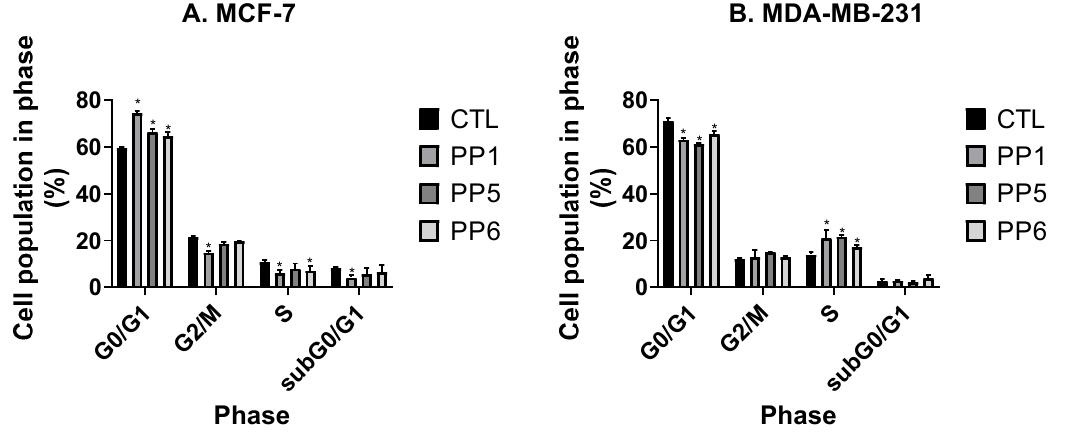
Figure 4. PP1, PP5, and PP6 block MCF-7 cells in G0 / G1 and increase the proportion of MDA-MB-231 cells in G0 / G1. MCF-7 ( A ) and MDA-MB-231 ( B ) (2.5 × 10 5 cells / well) were seeded in six-well-plates in complete media. 24 h later, cells were incubated with media containing 1% FBS and 100 µ M PhytoPs or vehicle alone (Ctrl) and incubated for 48 h. Cells were then subjected to cell cycle analysis as when compared to the control group: *, p < 0.05.